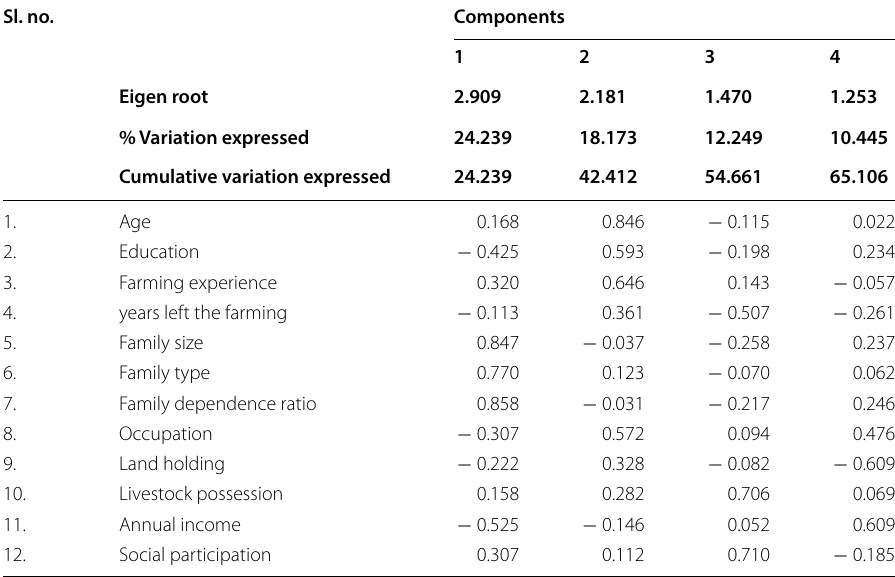
Table 5 Contribution of factors on agricultural landholders for avoiding farming as profession ( n 100) = Sl.